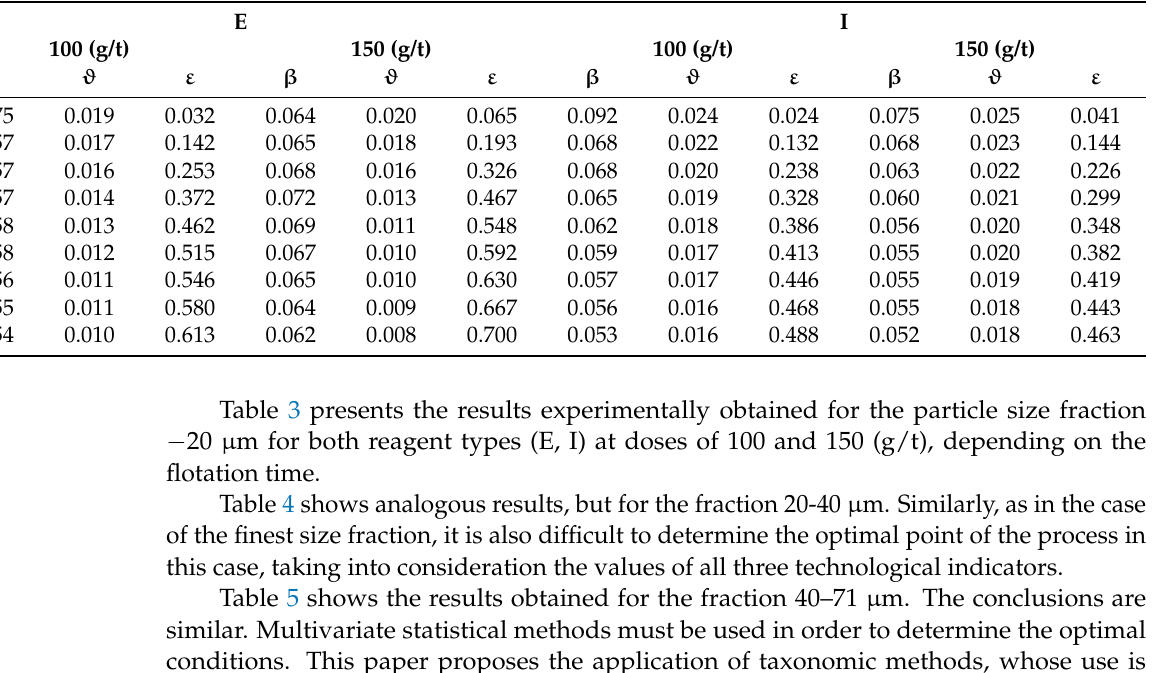
Table 5. Results of measurements for particle size fraction 40–71 µ